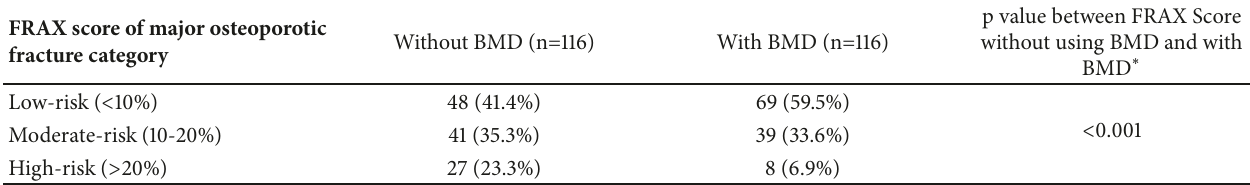
Table 4: The 10-year probability of major osteoporotic fracture. Without vs with using BMD on